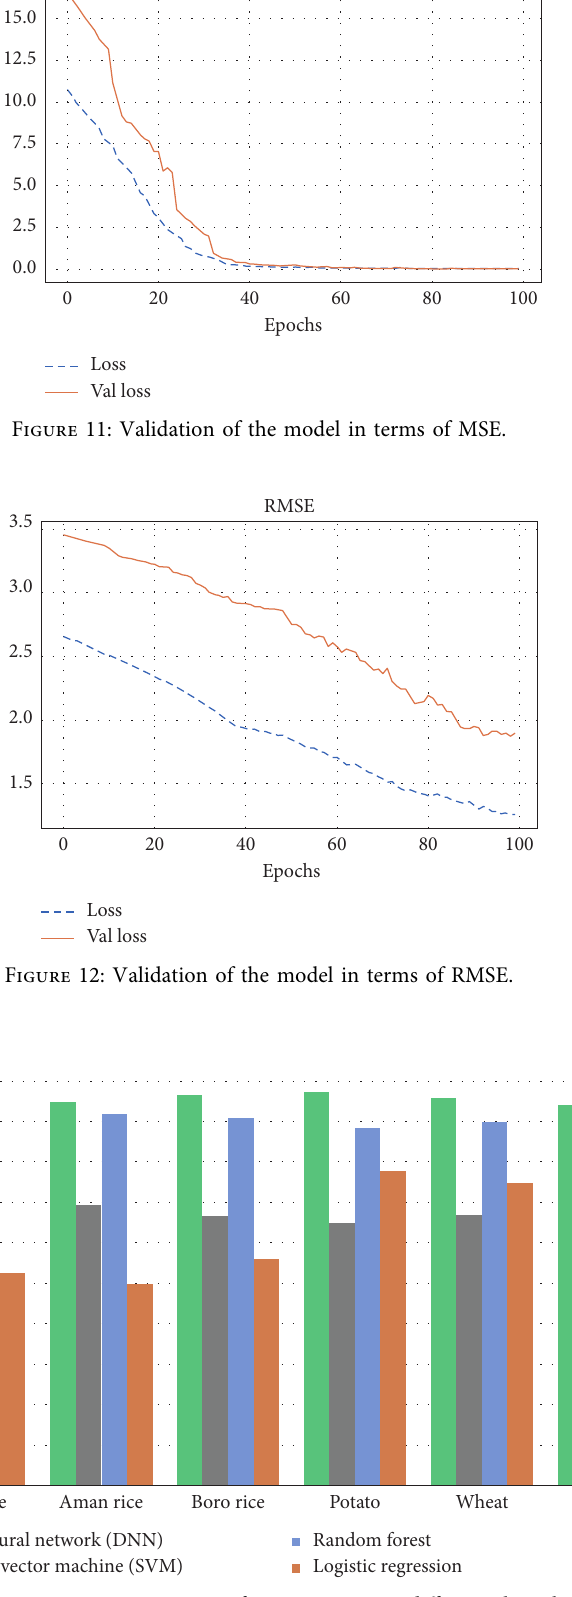
Figure 13: Accuracy percentage of various crops in different